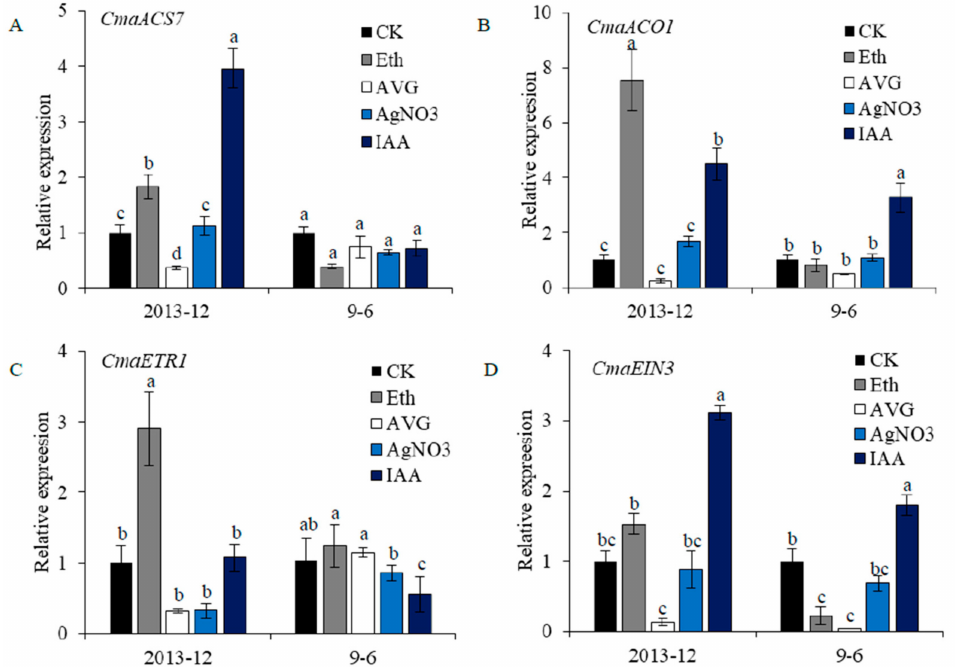
Figure 8. Expression changes of CmaACS7 ( A ), CmaACO1 ( B ), CmaETR1 ( C ) and CmaEIN3 ( D ) after Ethrel (Eth), aminoethoxyvinyl glycine (AVG), AgNO 3 and indoleacetic acid (IAA) treatment. The expression level of CmaACS7 , CmaACO1 , CmaETR1 and CmaEIN3 were detected using qRT-PCR. Gene expression of control (CK) ‘2013–12’ was assumed as 1 in chemical treatment ‘2013–12’, and control (CK) ‘9–6’ was assumed as one in chemical treatment ‘9–6’. Data are displayed as the ratio of expression to CmaActin with three biological replicates. Error bars represent standard error (SE). The qRT-PCR of primers used are given in Table S3. Phytohormone levels followed by the